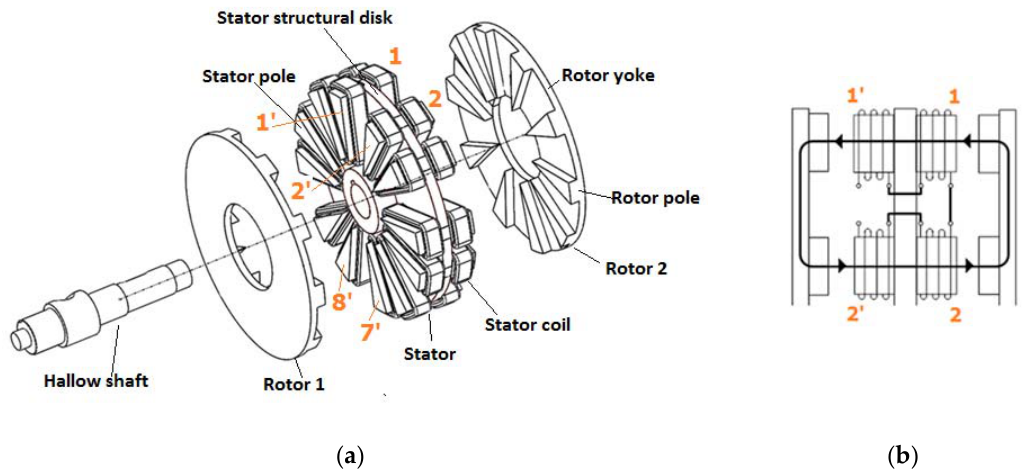
Figure 1. ( a ) Exploded view of the proposed axial-flux switched reluctance machines (AFSRM) ( left ), ( b ) representation of the flux path when there is alignment between stator and rotor poles ( right ) [15].